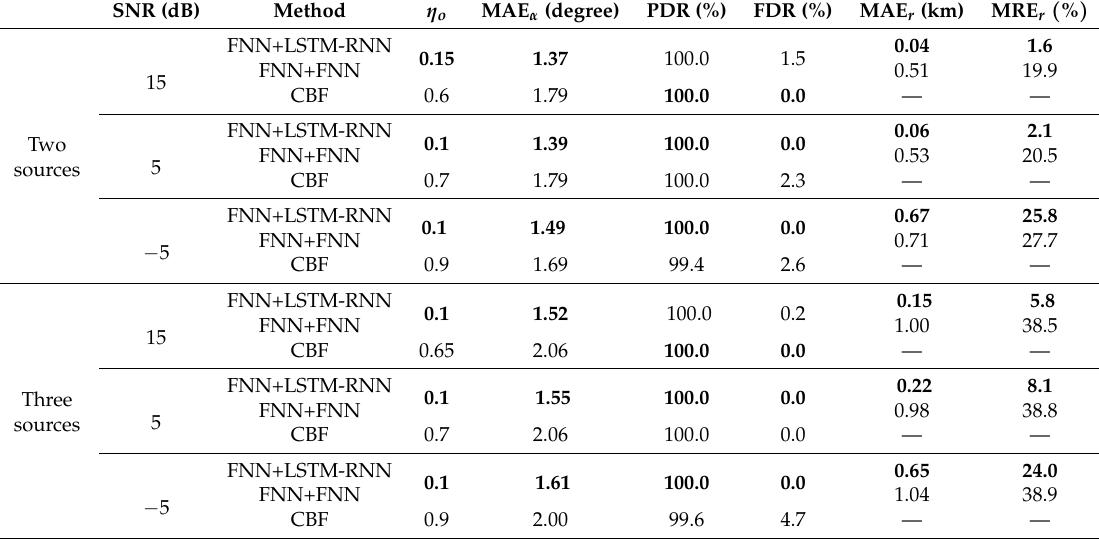
Table 3. The performance comparison under different SNRs in the two-source and three-source scenarios using the simulated data on HLA.